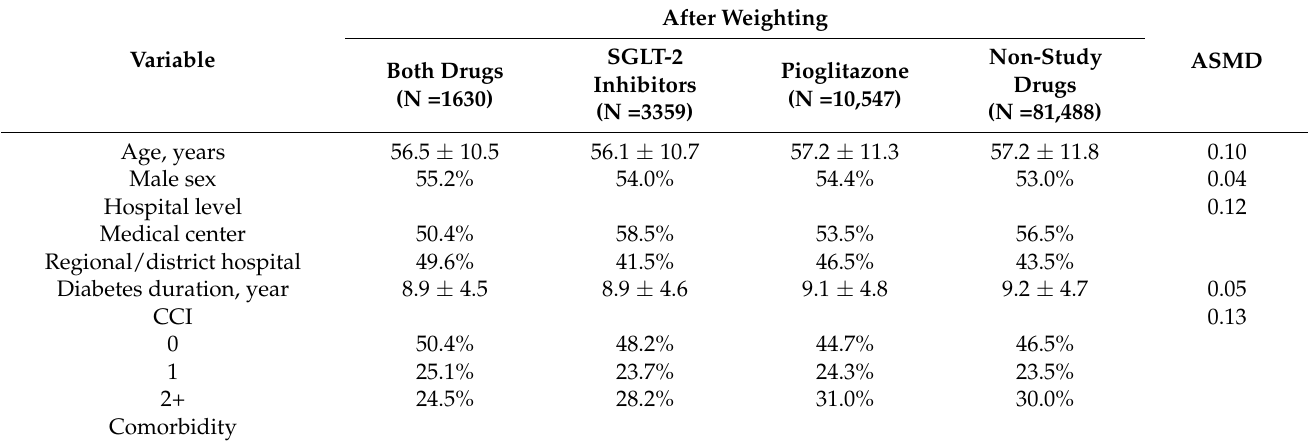
Table 2. Demographic characteristics of the study population after propensity score